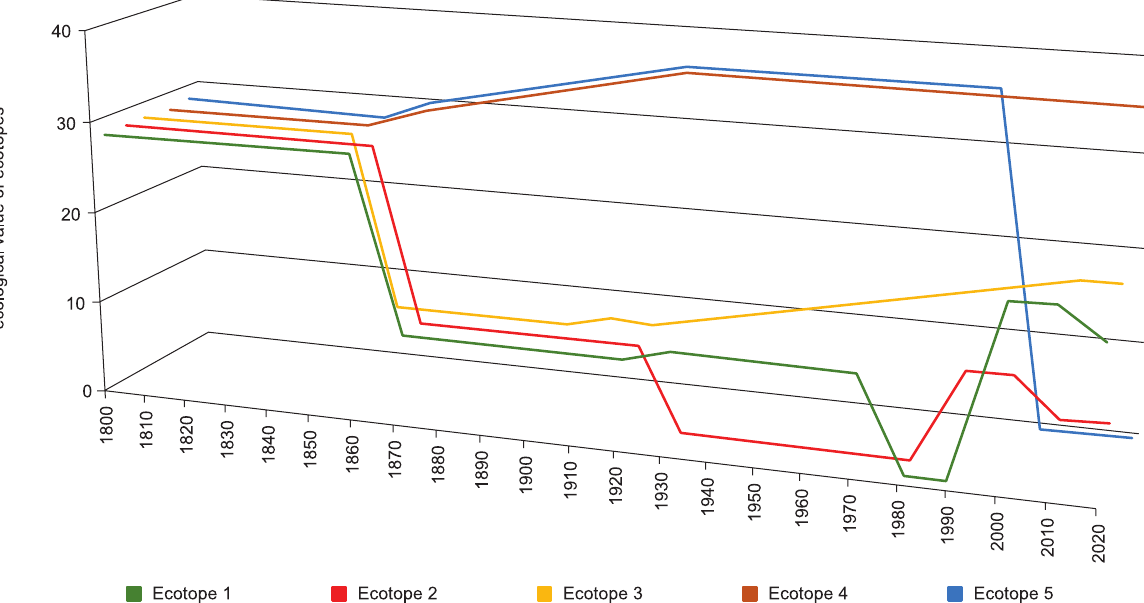
Fig. 5. Development of ecological value of ecotopes in the Sulkov site. Source: own processing, point values of habitats according to the Hessian scoring methodology (Seják 2005, Seják et al.